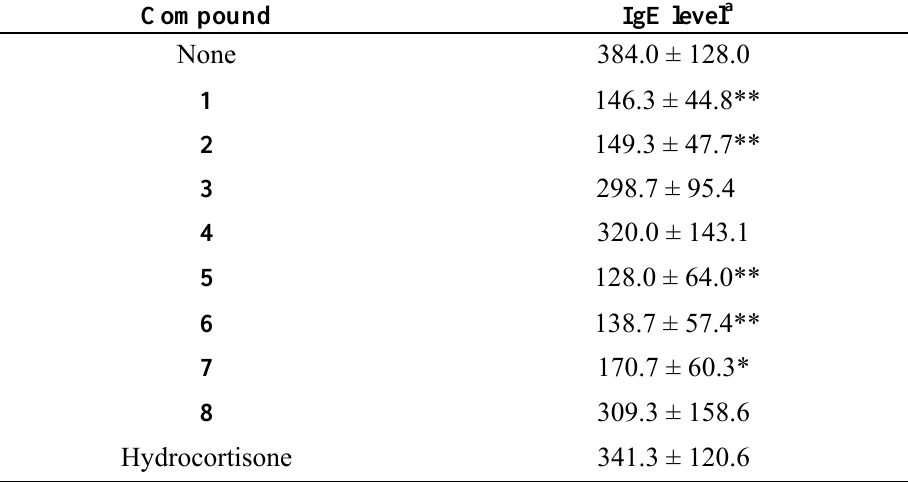
Table 1. Effects of tocopheryl β -glycosides 2 - 4 and 6 - 8 on IgE antibody formation.